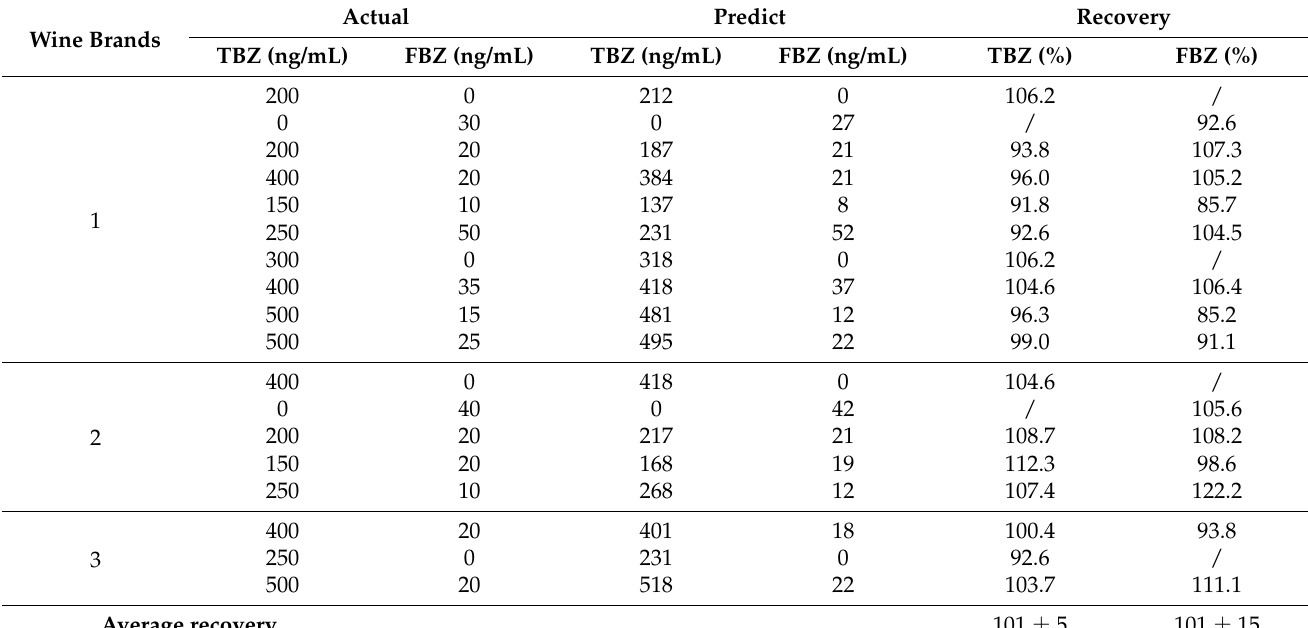
Table 7. Predicted results of dilution method combined with support vector regression